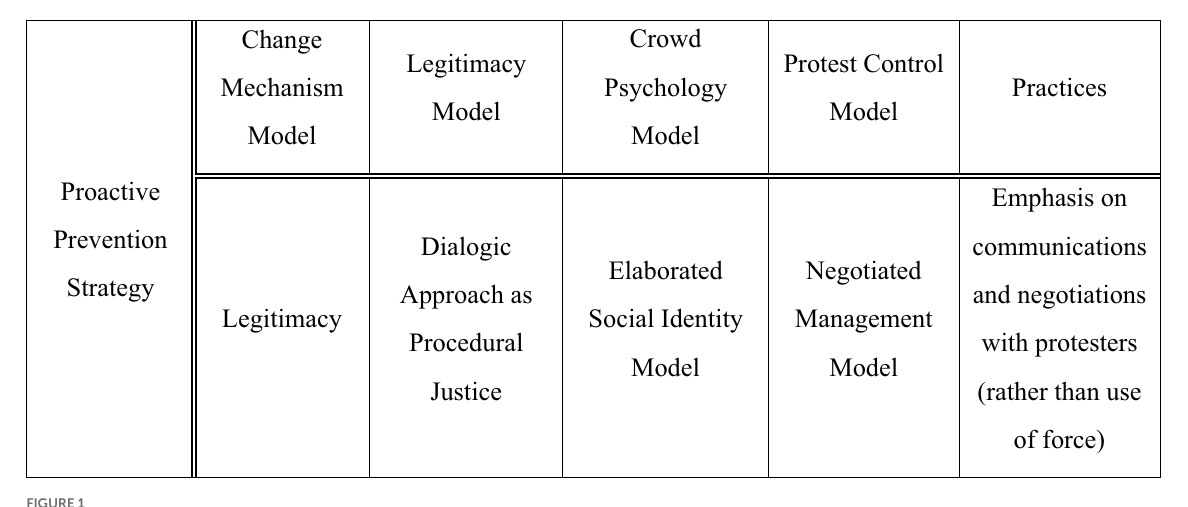
FIGURE 1 Theoretical background – framework of